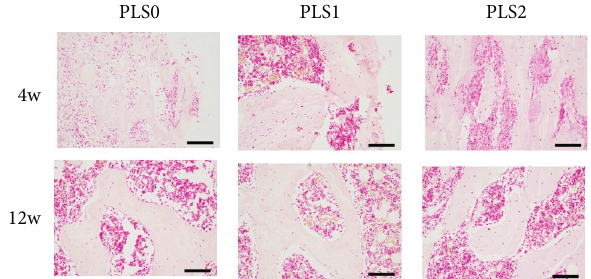
Figure 3: HE staining after treatment for femoral head necrosis (40x).